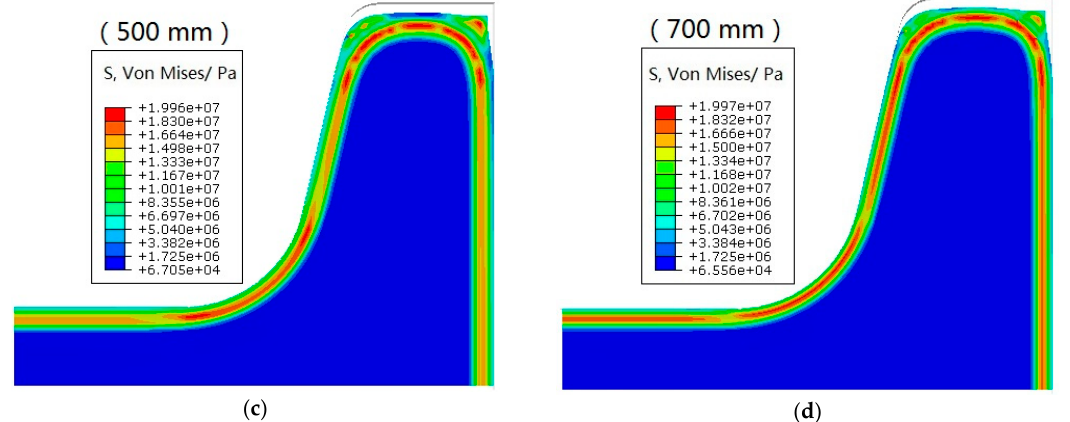
Figure 6. Equivalent stress contours at depths from the meniscus of ( a ) 100 mm; ( b ) 300 mm; ( c ) 500 mm and ( d ) 700 mm in the mold.